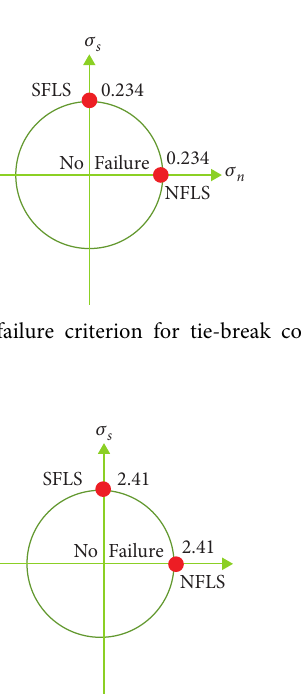
Figure 21: Tie bar failure criterion for tie-break contact (unit: 1 × 10 6